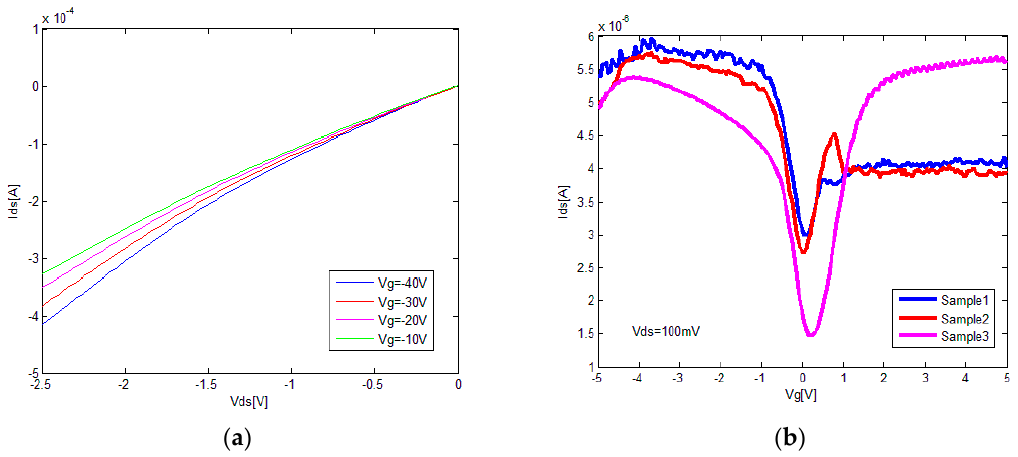
Figure 7. Electrical characteristics of the graphene-based FETs. ( a ) Output curves of the graphene-based FET for V ds = 0–2.5 V, with V g ranging from − 40 to − 10 V; ( b ) transfer curves of the graphene-based FETs at V g = − 5–5 V and a fixed V ds of 100 mV.